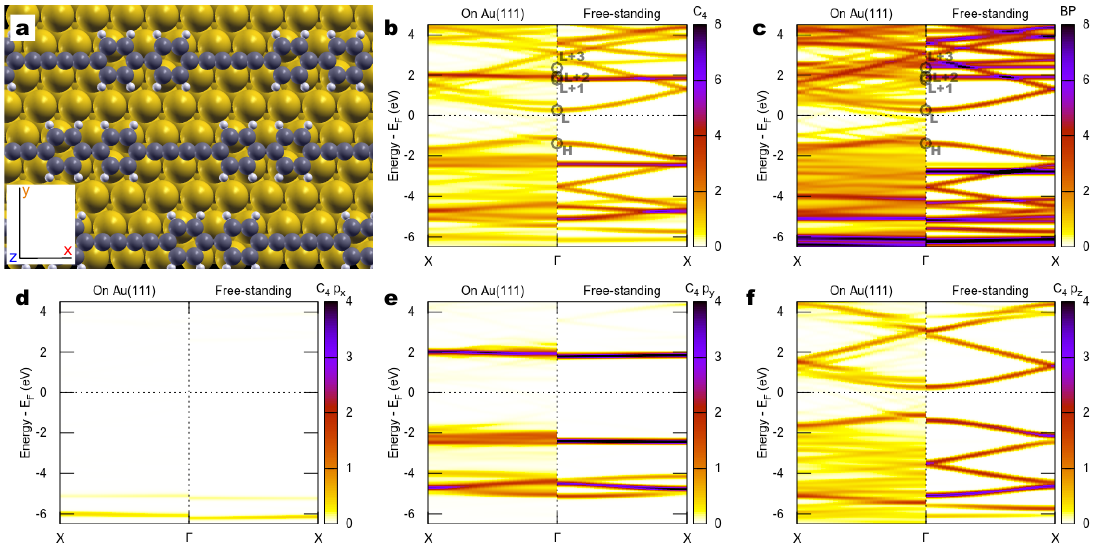
Figure 3. ( a ) Structural model of bBEBP/Au(111). ( b , c ) Electronic band structure projected on the C atoms belonging to the C 4 section and the biphenyl one, respectively. Left and right panels report the calculations on Au(111) and free-standing, respectively. Darker colors indicate stronger localization over the C atoms, whereas white area denote the absence of electronic state projecting over the selected set of orbitals at that energy. The labeled circles mark the energy of highest occupied (H) and lowest unoccupied (L) electronic states, computed for the free-standing polymer, depicted in Figure 4. ( d – f ) The same band structure projected on the p x , p y , and p z orbitals of the C 4 part.